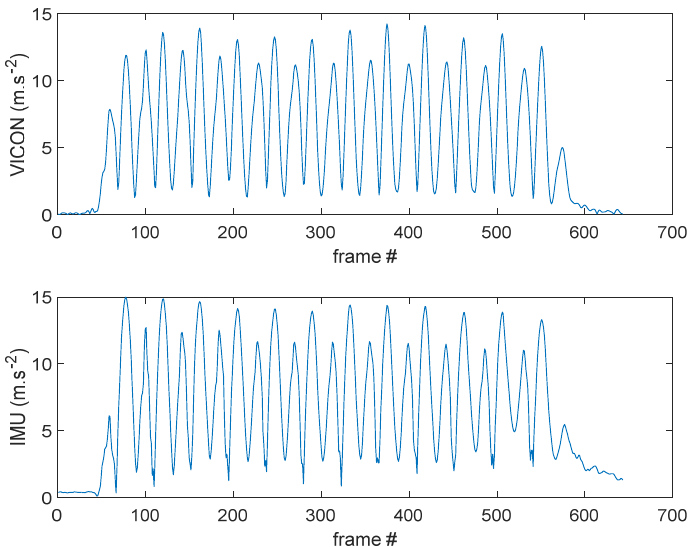
Figure A2. VICON and IMU signals after cross-correlation synchronization .